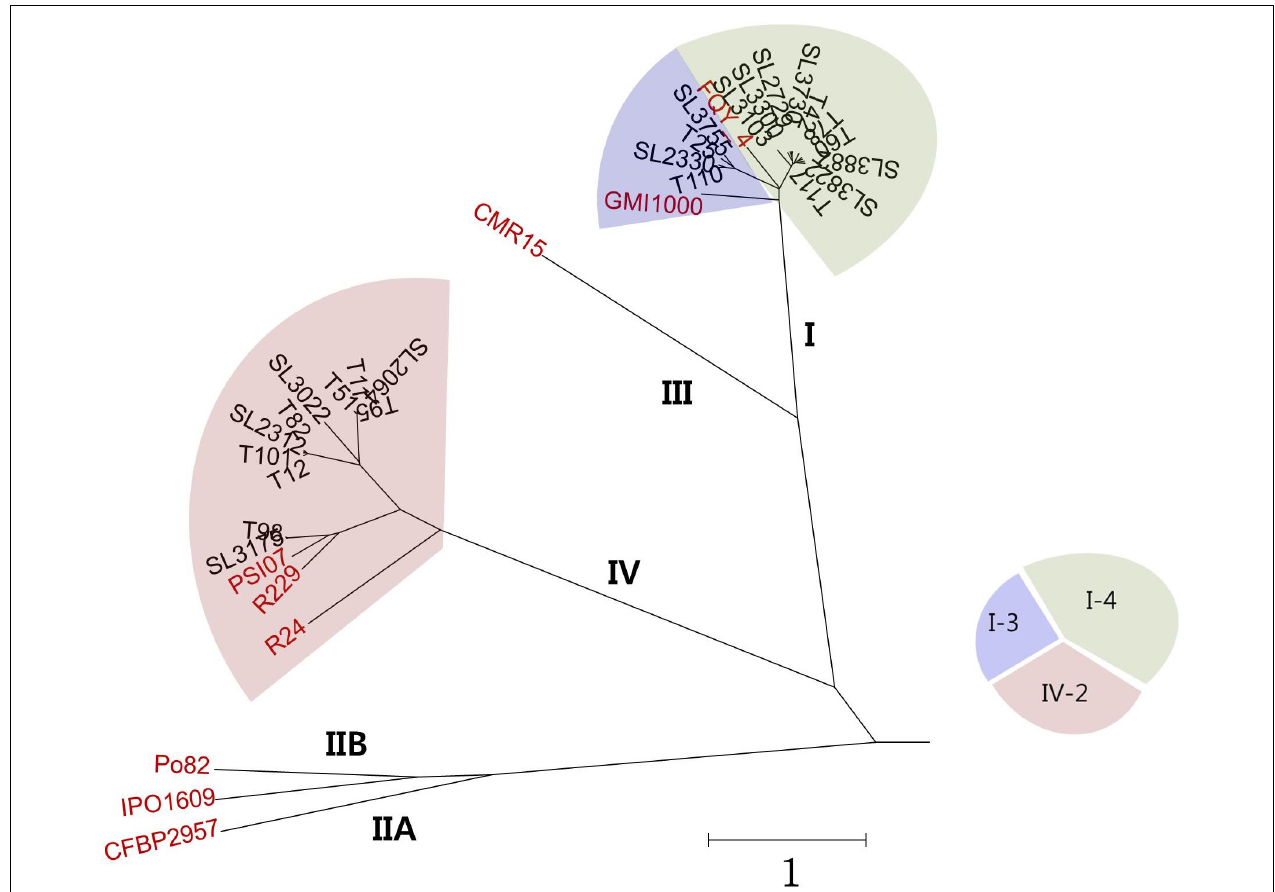
FIGURE 1 | Phylogenetic tree prepared using genomes of 25 Korean and 9 reference RSSC strains based on OrthoANI